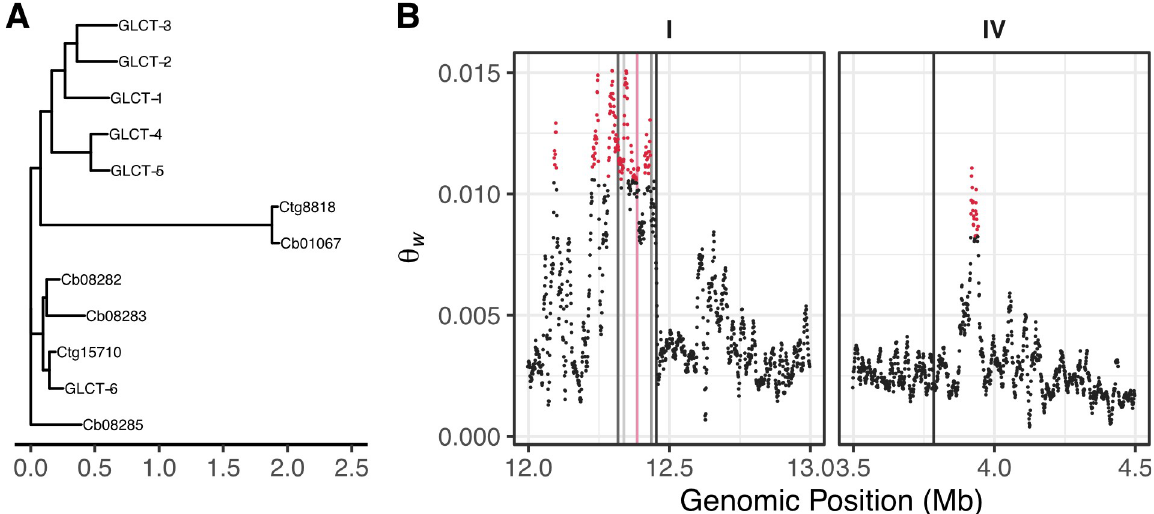
Fig 5. Expansion of the glct family. (A) An unrooted maximum-likelihood phylogeny of the six glucuronosyl transferase-like protein sequences encoded by the C . elegans genome and homologs from C . briggsae (Cb) and C . tropicalis (Ct). (B) The genetic diversity as measured by Watterson’s theta ( Θ w) for the genomic regions that contain the six glucuronosyl transferase-like genes in C . elegans is shown. Each vertical line marks the position of a glct gene, from left to right on chromosome I: glct-4 , glct-1 , glct-3 (pink), glct-2 , and glct-5 ; and chromosome IV: glct-6 . Each dot represents a 10,000 bp genomic region and is colored red if the Θ w value is greater than the 99th quantile of values across the chromosome.